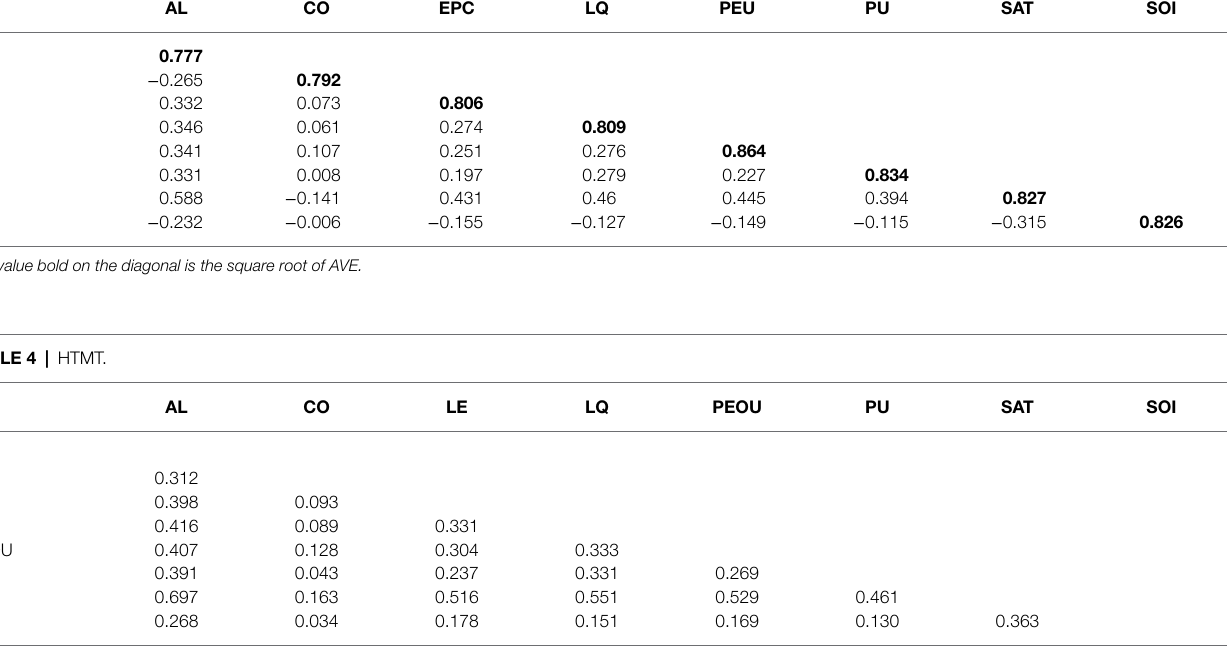
TABLE 3 | Correlation coefficient between latent variables and square root of AVE. AL CO EPC LQ PEU PU SAT SOI AL